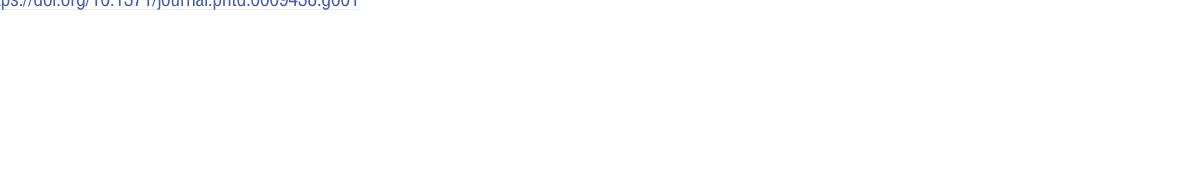
PLOS NeglectedTropical Diseases | https://doi.org/10.1371/journal.pntd.0009438 August 20, 2021 5 /